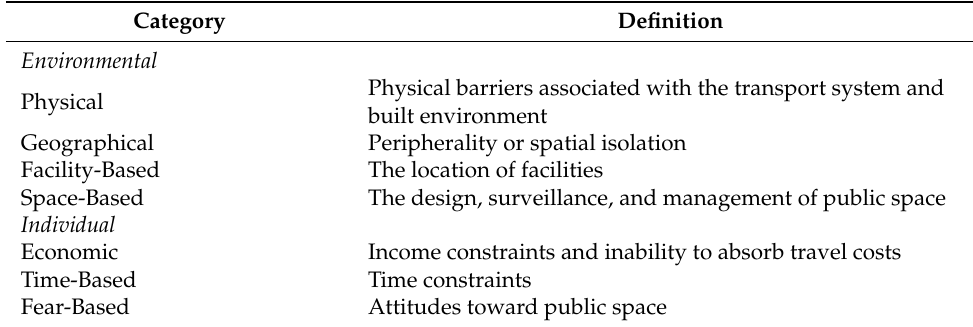
Table 1. Definition of the categories of factors from the a priori